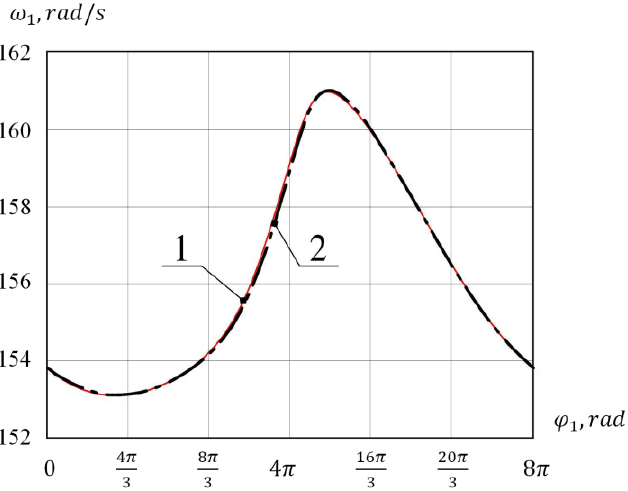
Figure 10. Graphs of function ω 1 ( ϕ 1 ) with flywheel: 1—the energy-mass method, 2—the third-order Hermite interpolation function.